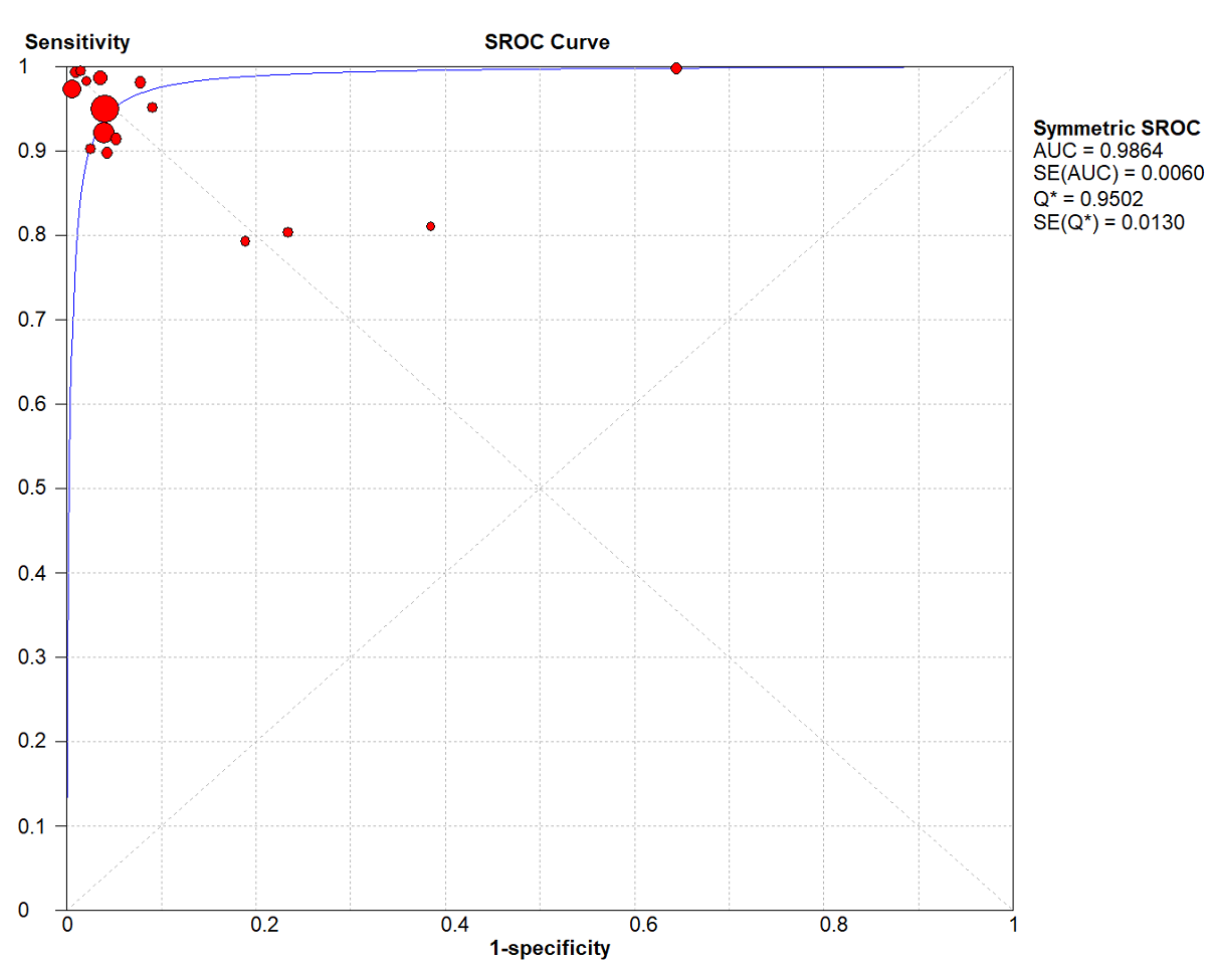
Figure 3. Summary receiver operating characteristic (SROC) curve of the deep learning method. AUC: area under the curve; Q*: this index is defined by the point where sensitivity and specificity are